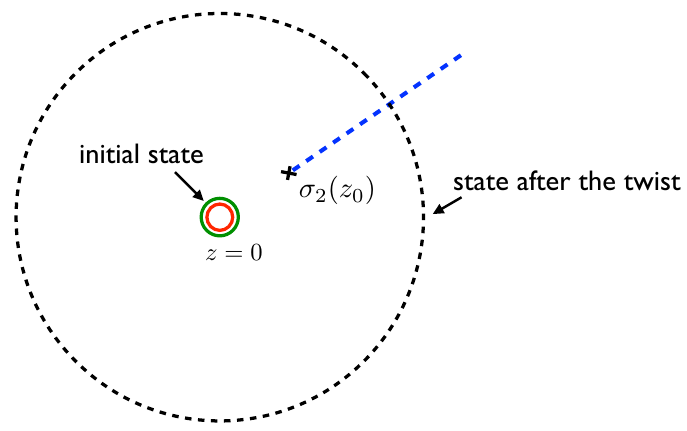
Figure 1 . The effect of a twist operator. The red and green circles represent the states living on two separate copies located before the twist operator. The twist operator produces a branch cut from z 0 to infinity. The dashed circle represents the state living on the joined copy with two